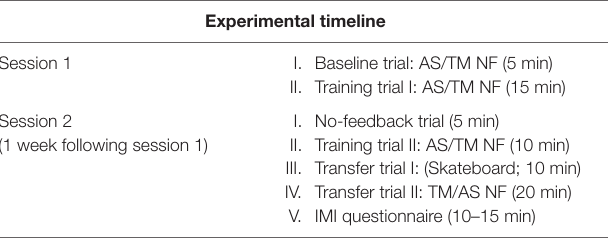
TaBle 1 | experimental design.